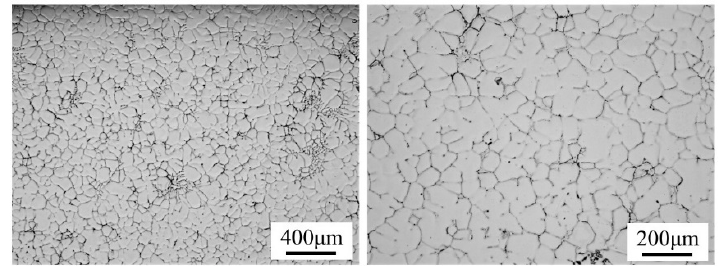
Figure 5. Metallographic structure of as-cast AA6063 at the center locations.